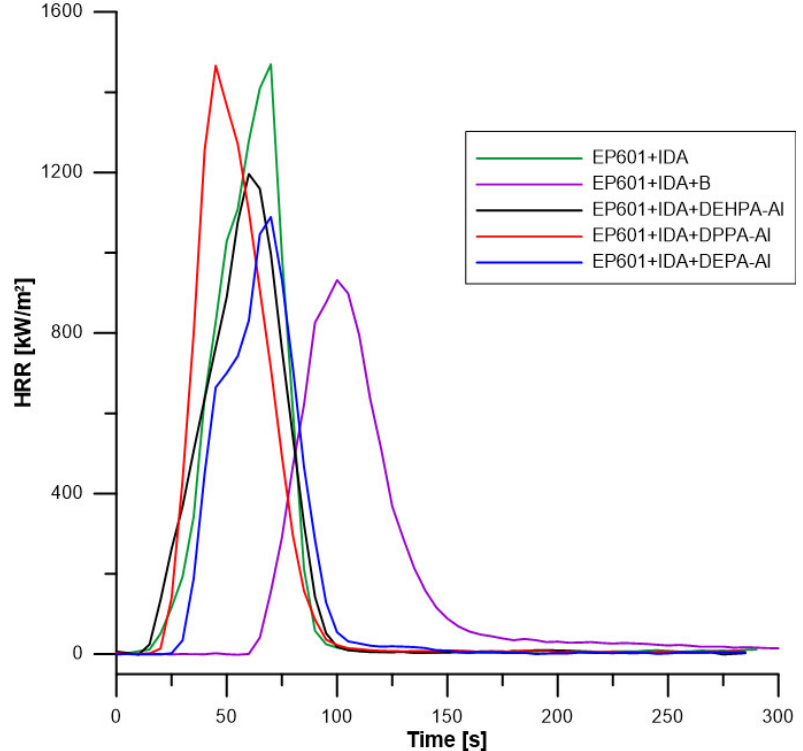
Figure 10. Cone calorimetry graphs for obtained composites. Table 7. Results from cone calorimetry.